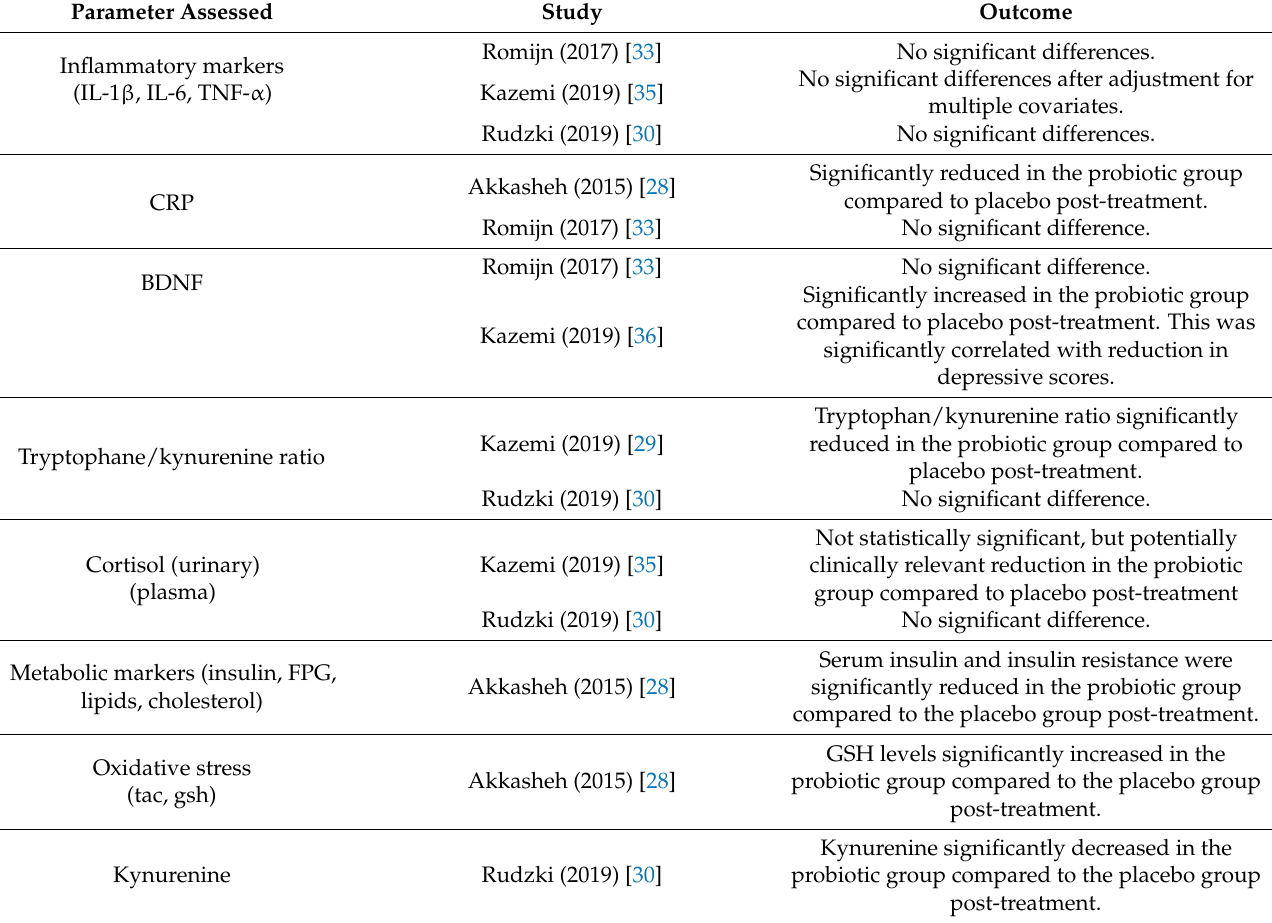
Table 2. Biomarkers assessed in the included studies and corresponding findings (most frequently measured first). Parameter Assessed